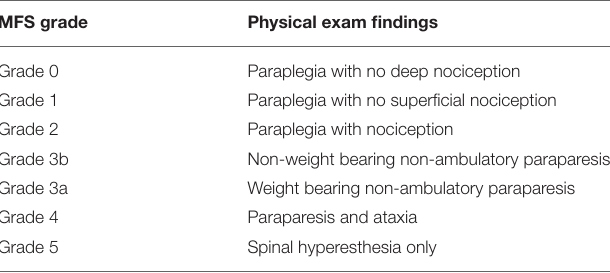
TABLE 1 | Modified Frankel